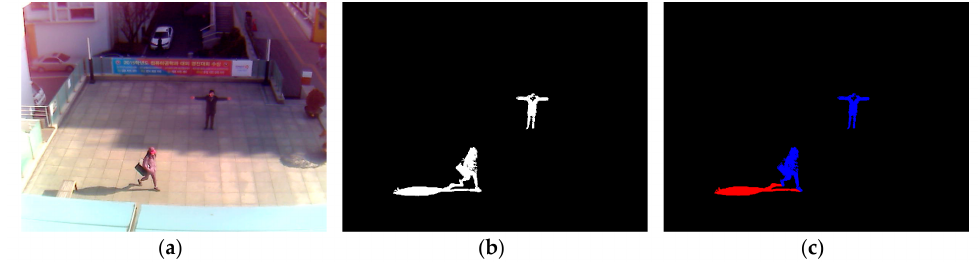
Figure 2. Example of input image, the result of foreground detection, and ground-truth image of non-shadow (human) and shadow areas. ( a ) Input image; ( b ) Result of foreground detection; ( c ) Ground-truth image of non-shadow (blue color) and shadow (red color) areas.